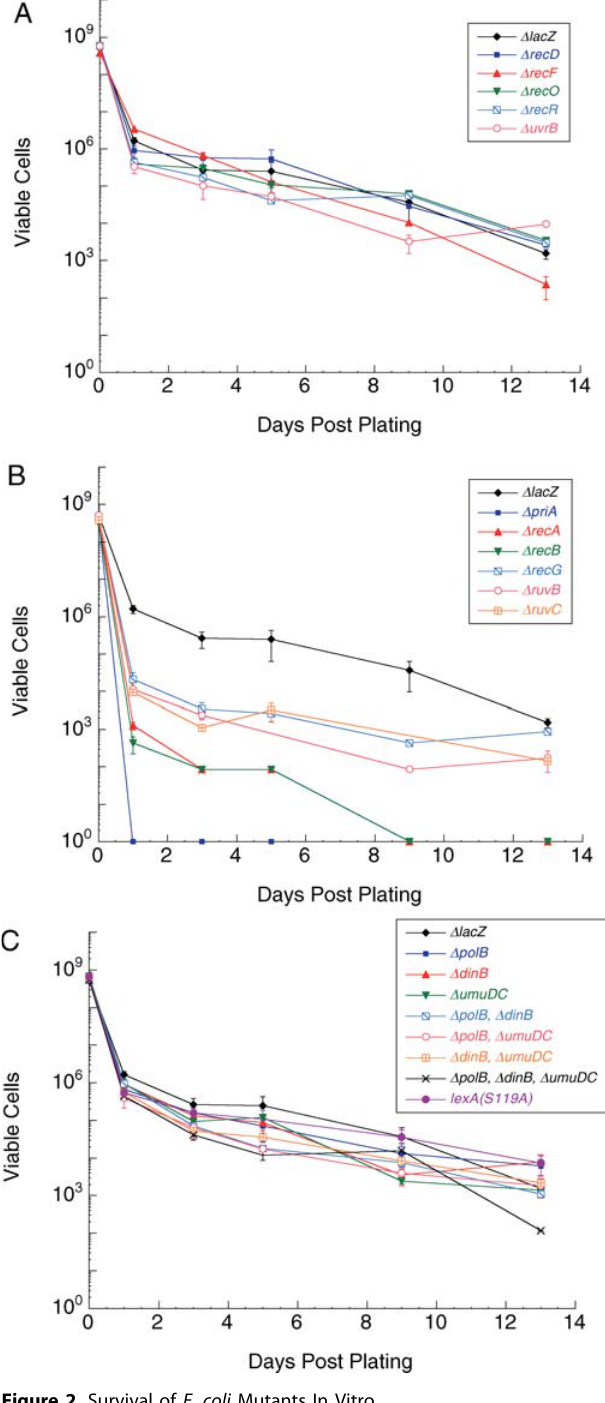
Figure 2. Survival of E. coli Mutants In Vitro Survival on solid media containing 40 ng/ml ciprofloxacin of D lacZ control and (A) NER and recombination mutants with wild-type sensitivity, (B) recombination mutants that were hypersensitive to ciprofloxacin, and (C) lexA (S119A) and inducible polymerase